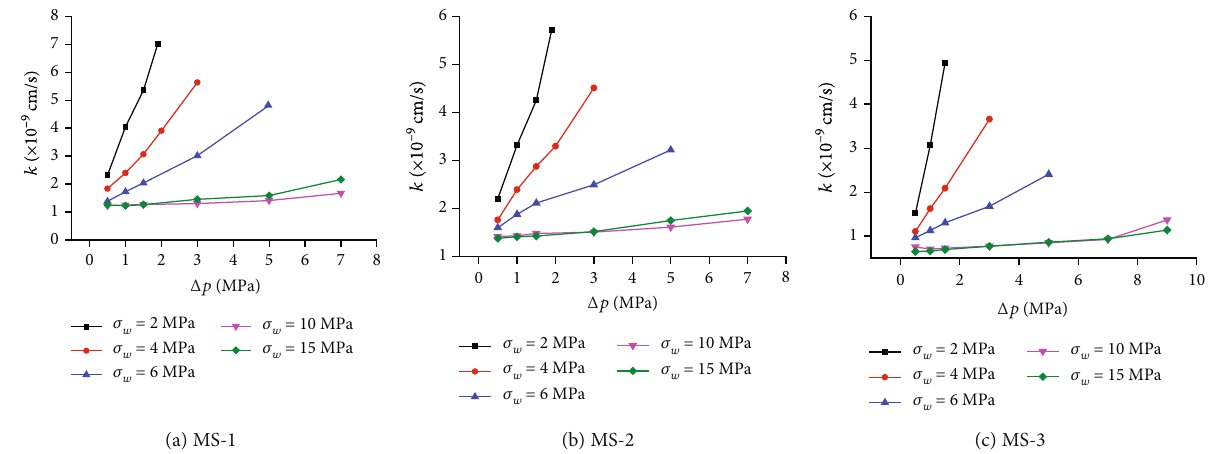
Figure 16: Relationship between permeability coe ffi cient and water pressure for